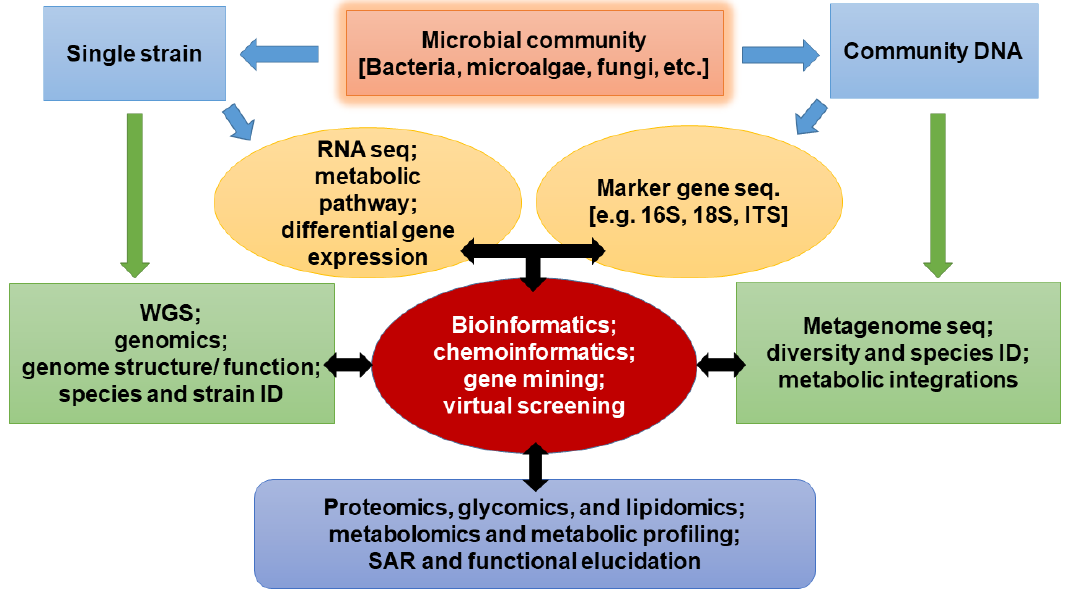
Figure 2. A typical workflow for omics, integrating molecular, chemical, and computational science to elucidate the potential of microorganisms and molecules for therapeutics.